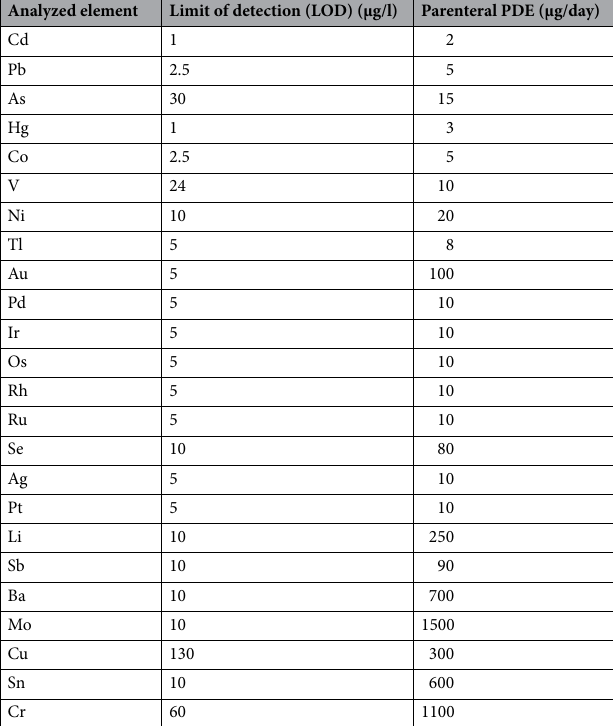
Table 2. ICP MS results of NE’X glue.